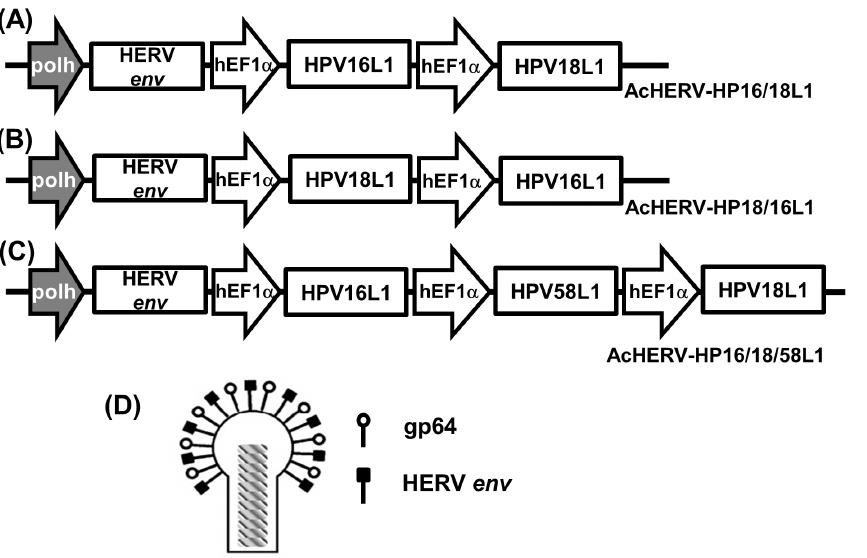
Figure 2. Construction of recombinant baculoviruses encoding HPV 16L1 or HPV 18L1 or HPV 58L1. Bivalent AcHERV-HP16/18L1 (A), AcHERV-HP18/16L1 (B), and trivalent AcHERV-HP16/18/58L1 (C) were constructed to contain the hEF1 a promoter controlling L1 protein expression and the Polh promoter controlling HERV envelope expression. (D) AcHERV-based recombinant baculoviruses were generated using the Bac-to-Bac expression